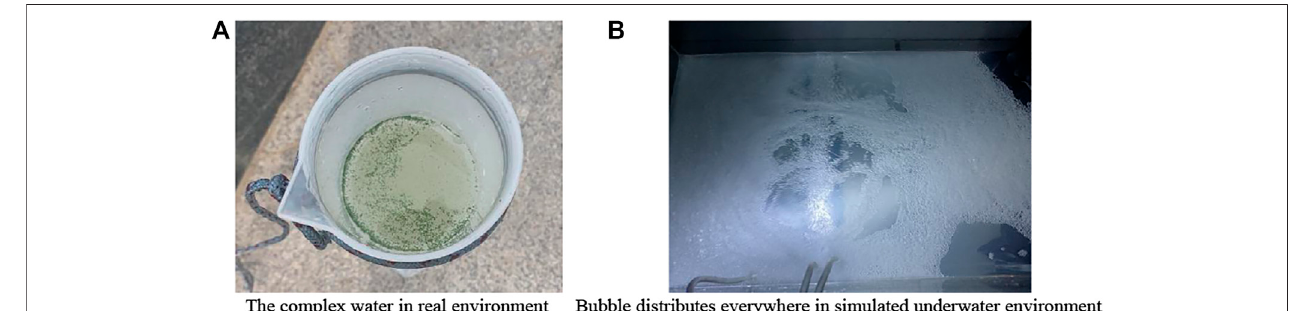
FIGURE1| Coexistenceofsuspendedmediumandrisingairbubblesinunderwaterenvironment. (A) Thecomplexwaterinrealenvironment (B) Bubbledistributes everywhere in simulated underwater environment.